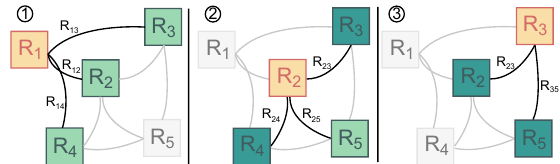
Figure 2: Construction of the graph and outlier detection: source for propagation (orange), rotations that are propagated to for the first time (light green), rotations that are propagated to and ex- hibit an estimation from previous propagation (dark green) and rotations that are not propagated to or stay fixed (grey). and v is equivalent to the three elements of the angle-axis rep- resentation of rotations v = α ˜v with angle α , α ∈ R ,